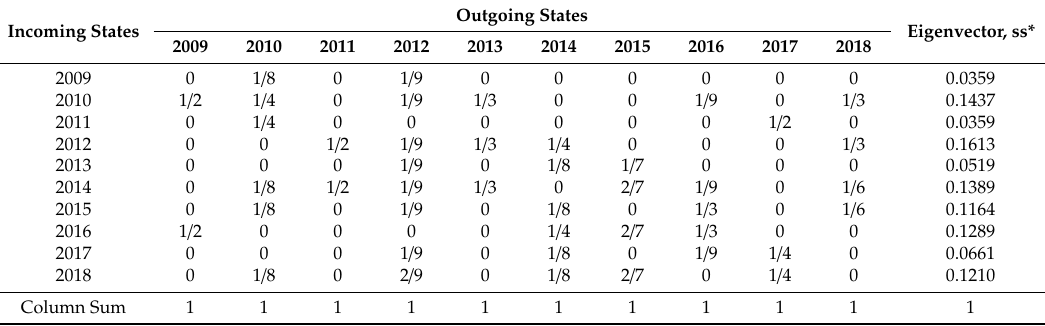
Table 3. Transition matrix of the Markov chain governing the random choice of annual PPMs and its dominant stochastic